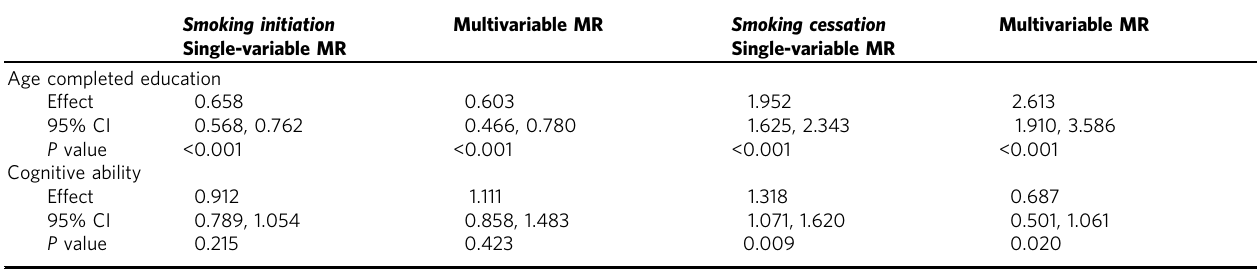
Table 4 Estimates of the effect of educational attainment and general cognitive ability; Odds ratio estimates from summary-level data